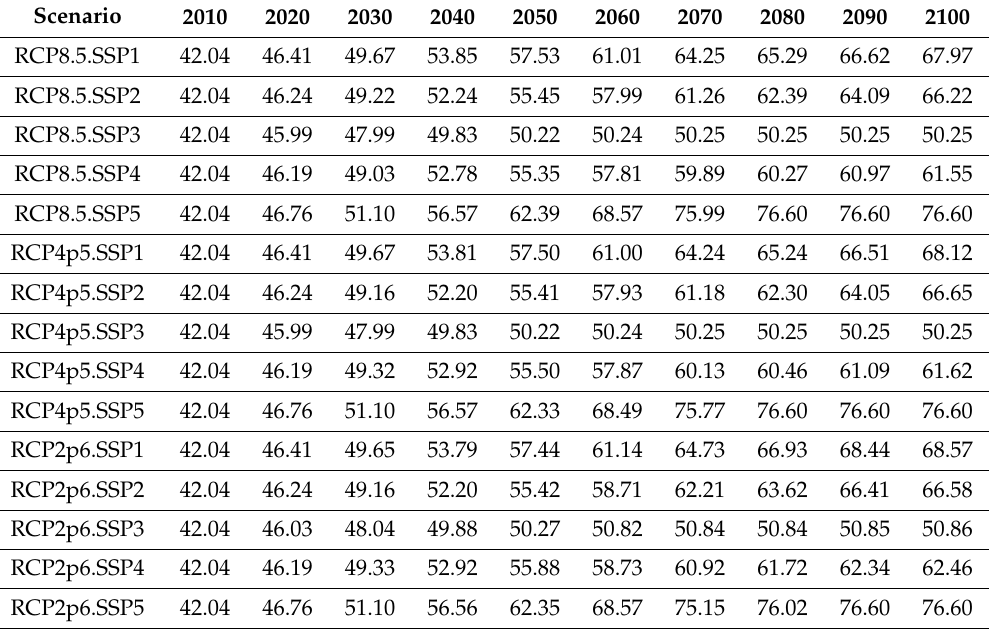
Table A10. Industrial roundwood harvest assortments—Sawlogs (millions of m 3 / year, under bark). Scenario